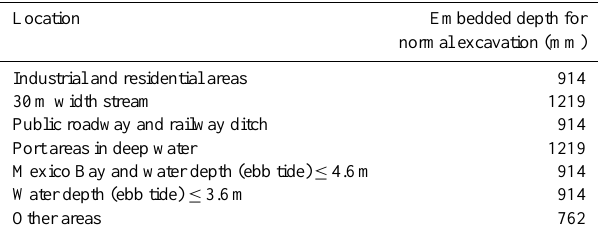
Table 3. Minimum embedded depth for buried pipeline (Office of Pipeline Safety Community (OPS),